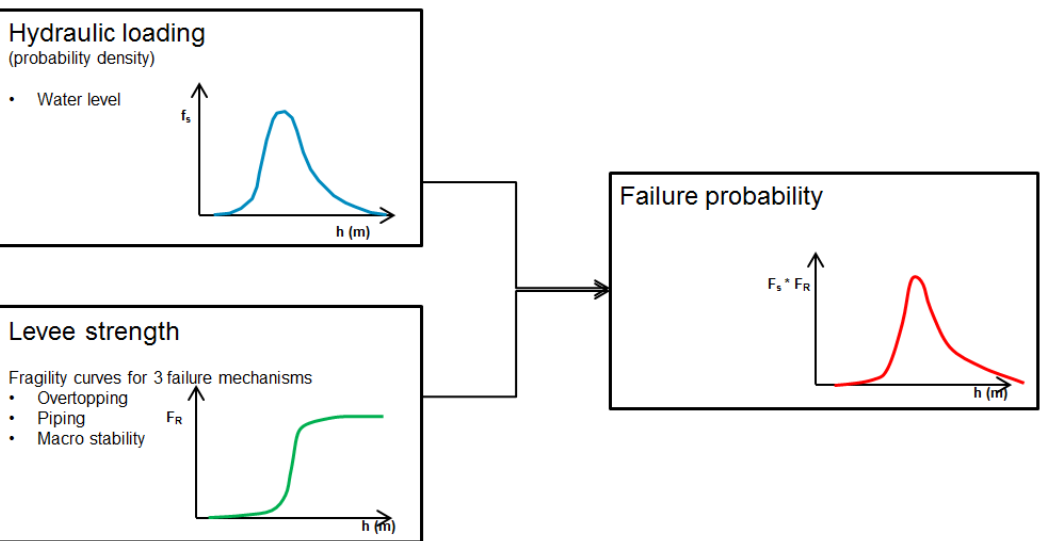
Figure 2. The failure probability of a flood defense at a certain location is a function of the probability density function of the flood water level and the strength of the flood defense expressed in a fragility curve (conditional probability of failure).